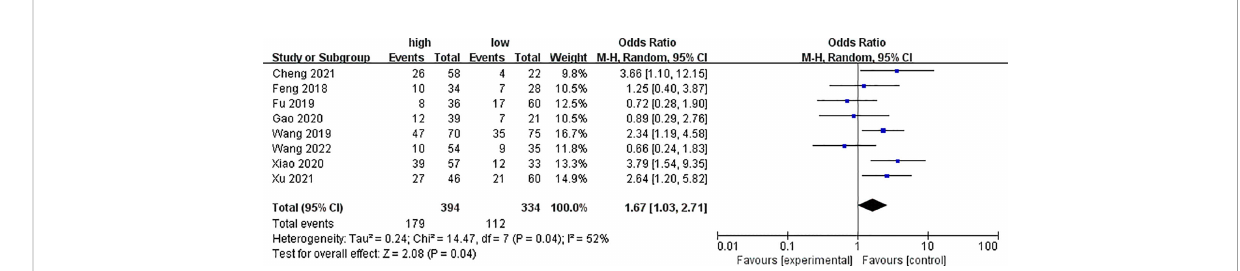
FIGURE 2 Forest plot of meta-analysis of the relationship between PYCR1 expression and the clinical stage of